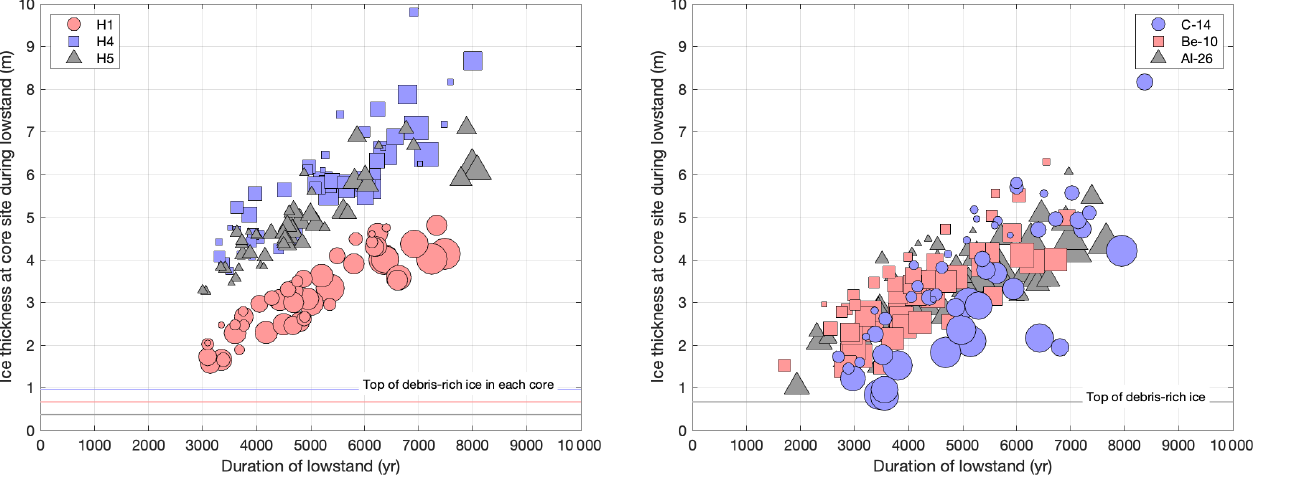
Figure 9. Trade-off between lowstand duration and ice thickness during lowstand in fitting measured 10 Be and 14 C concentrations. This shows the 50 (out of 2000) best-fitting iterations of the random search algorithm applied to each core, where the ice thickness his- tory in each iteration is simplified by representation as the duration of a Late Holocene ice thickness minimum and the mean ice thick- ness during that period. Relatively long lowstands with relatively thick ice fit the observations similarly to relatively short lowstands with relatively thin ice. The size of the symbols reflects goodness of fit: scenarios represented by larger symbols have lower values of M . For best readability, the symbol size is scaled to the respective range of M in each core. This highlights that scenarios with longer lowstand durations are slightly, but not strongly, favored. This figure also shows that ice thickness histories that fit data from each core are systematically offset: regardless of the duration of the lowstand, ice covering H1 is required to be ∼ 2m thinner during the lowstand than ice covering H4 and H5.